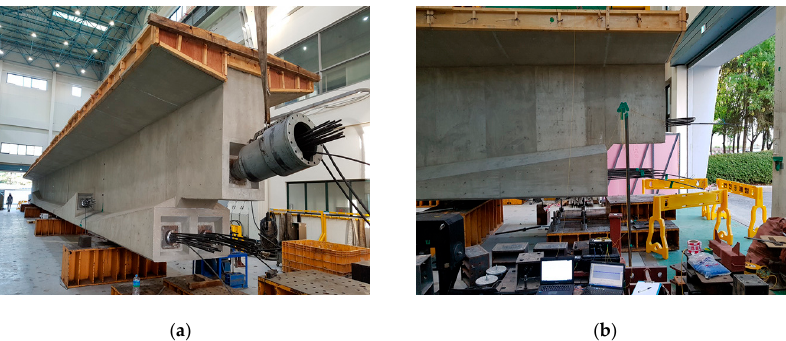
Figure 6. Full-scale BH girder bridge prototype: ( a ) Assemblage of precast segments; ( b ) Installation of OSPC strands.